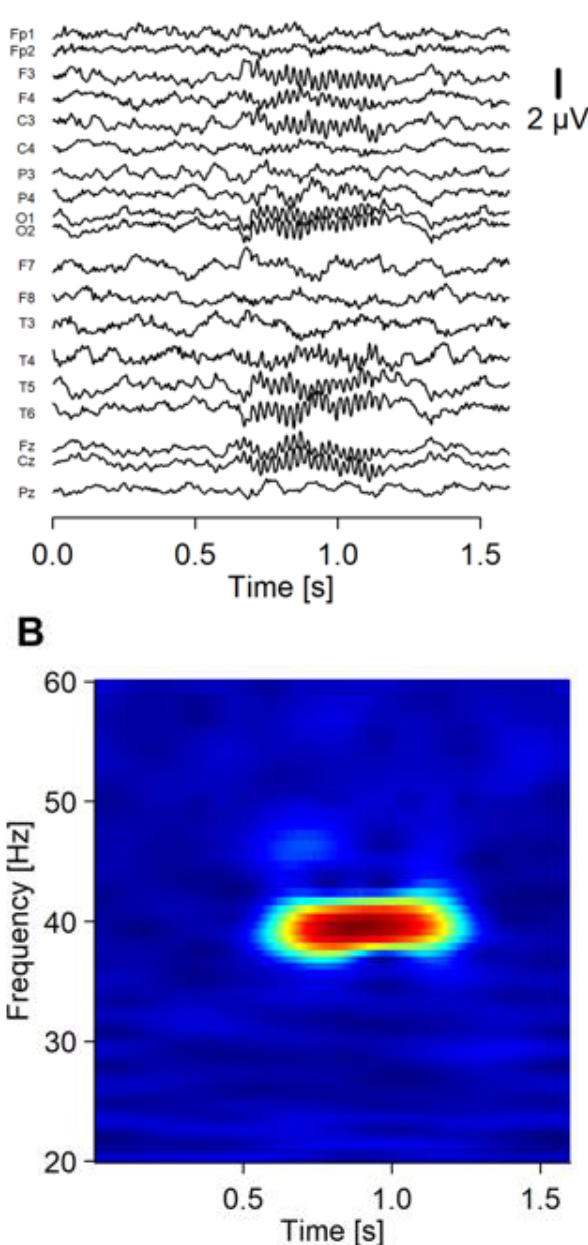
Figure 1. The averaged waveform and PLF of the ASSR of a representative patient. ( A ) Averaged waveform of the ASSR from 19 electrodes. The onset of the stimulus was at 0.5 ms of the x axis. ( B ) PLF of the ASSR shown in a heatmap.